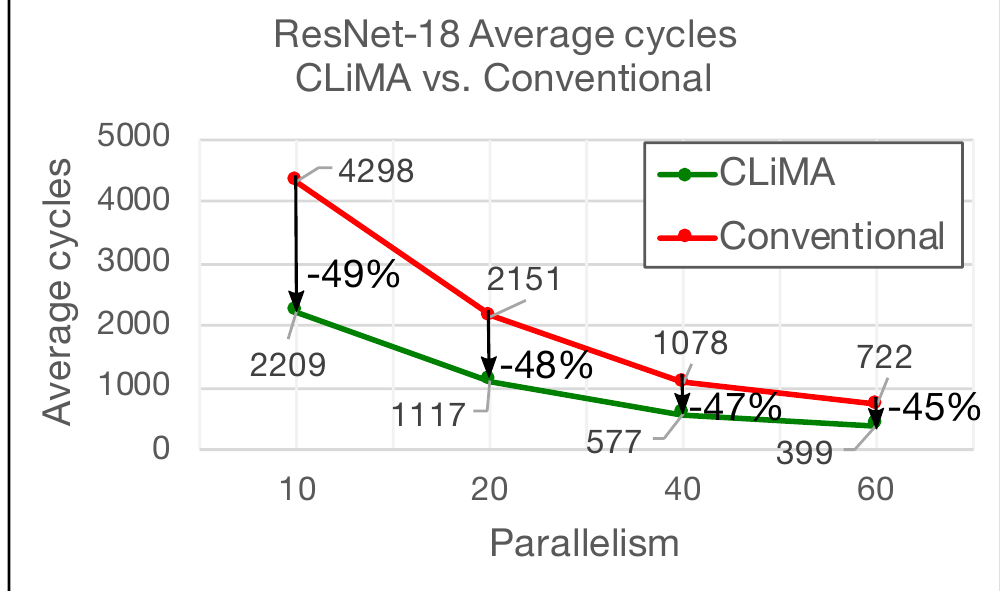
Figure 17. Average cycles needed to execute ResNet-18 in different scenarios: CLiMA vs.